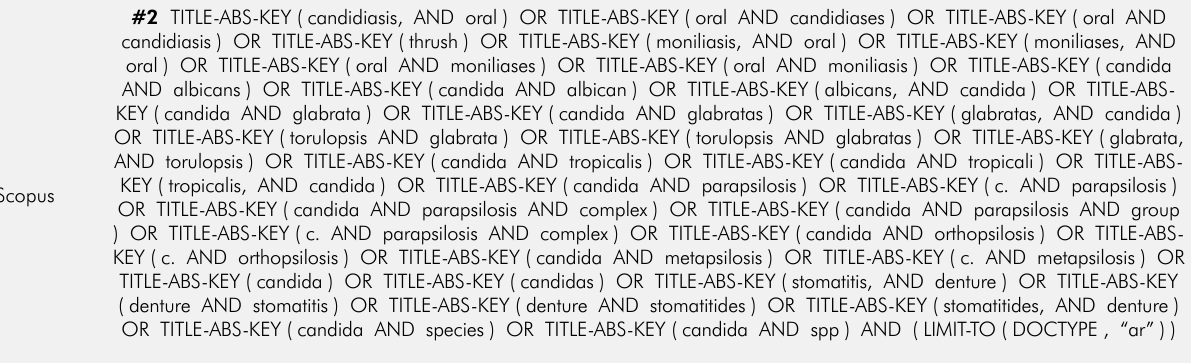
KEY ( candida AND glabrata ) OR TITLE-ABS-KEY ( candida AND glabratas ) OR TITLE-ABS-KEY ( glabratas, AND candida ) OR TITLE-ABS-KEY ( torulopsis AND glabrata ) OR TITLE-ABS-KEY ( torulopsis AND glabratas ) OR TITLE-ABS-KEY ( glabrata, Scopus